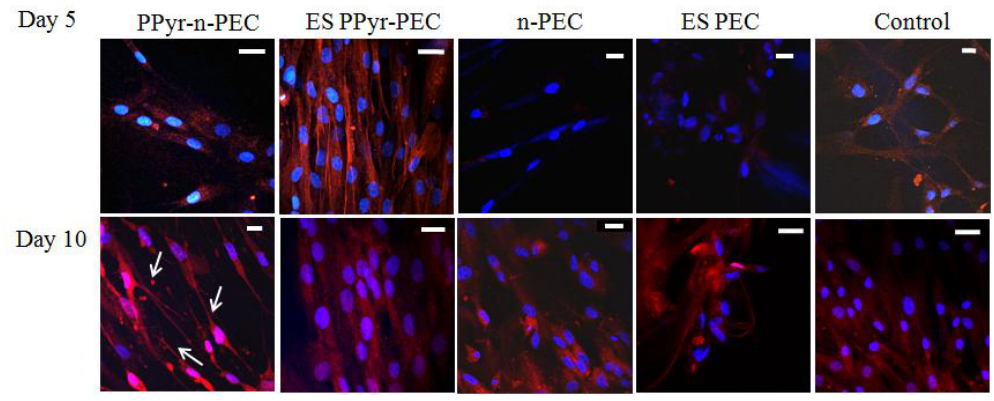
Figure 5. Immunofluorescent staining of synaptophysin in ES PPy-PEC, PPy-n-PEC, ES PEC, n-PEC and control samples at day 10. Control is hMSCs seeded on glass coverslips in the absence of electrical stimulation. Synaptophysin was stained with either Alexa Fluor 488 anti goat (green) or Alexa Fluor 568 anti rabbit (red) secondary antibodies. The cell nuclei in all panels were stained with DAPI and shown in